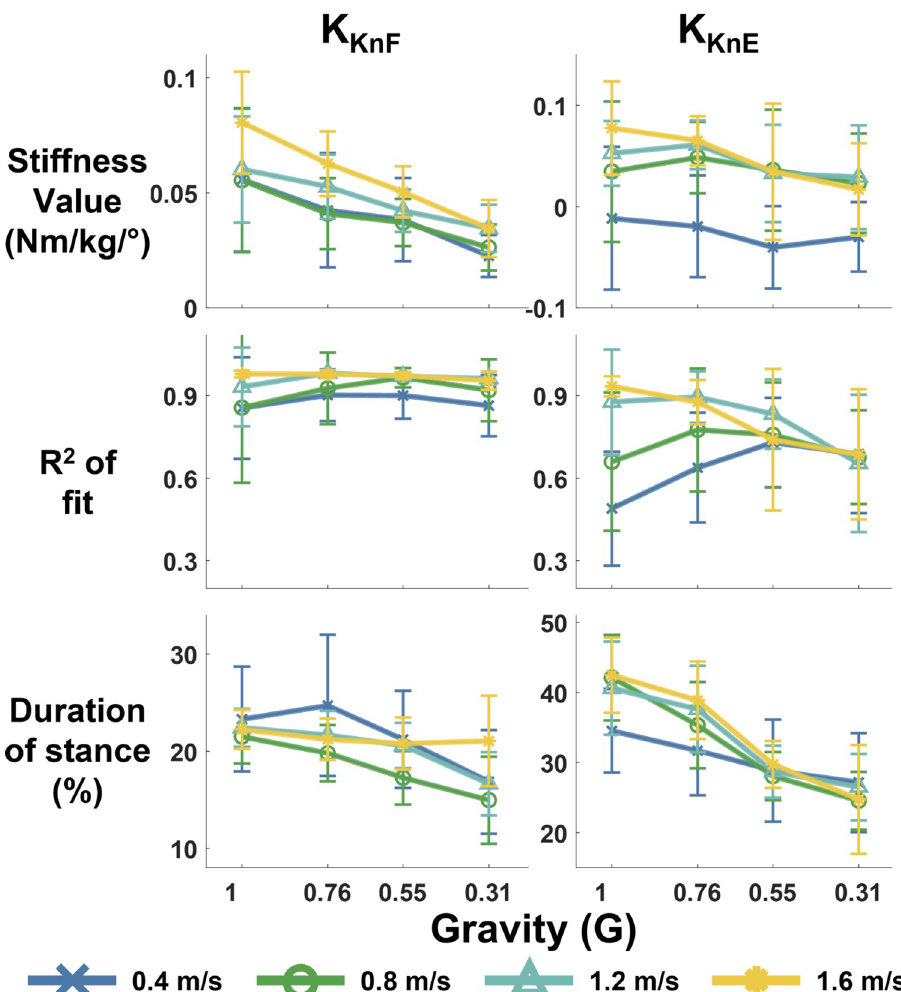
Fig 6. Quasi-stiffness of the knee in stance phase at different levels of simulated reduced gravity and speeds. Top row shows stiffness values, middle row is the quality of fit of the linear quasi-stiffness model, and bottom row is the duration of the quasi-stiffness phase as percent of stance phase. Each column of plots is a different quasi-stiffness phase for the knee: K KnF is flexion, and K KnE is knee extension. The error bars show standard